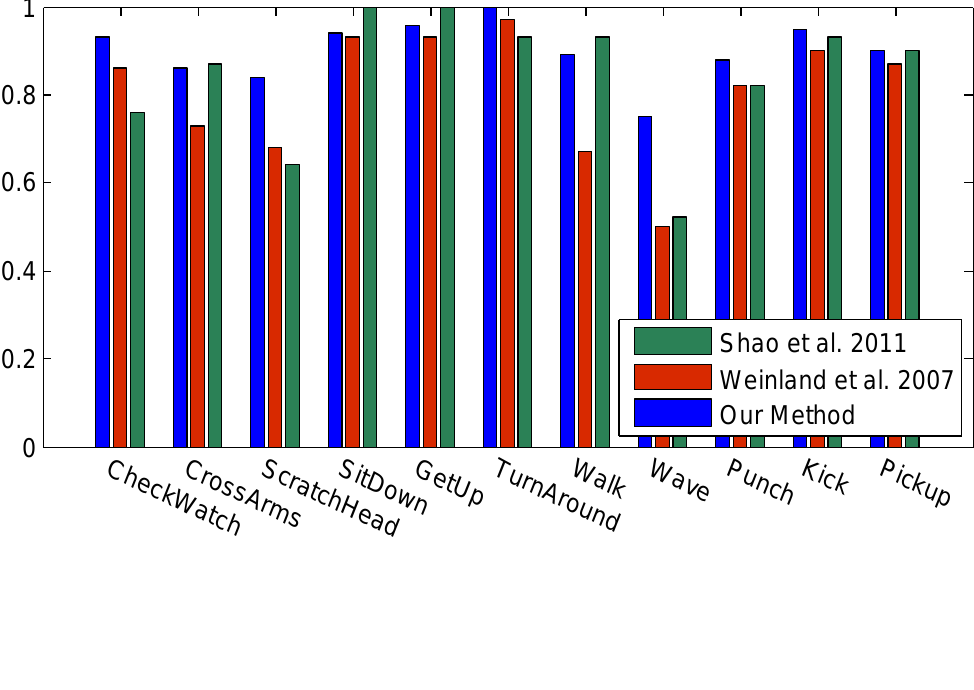
Figure 8. Class-level recognition results of the IXMAS dataset with 11 actions, in comparison with Shao et al . [50] and Weinland et al .